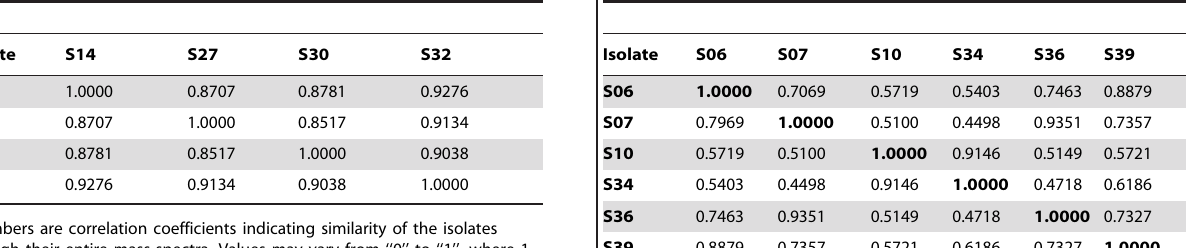
Table 3. CCV analysis of MALDI-TOF data of four Vibrio isolates using the in-house method developed for this study.*.